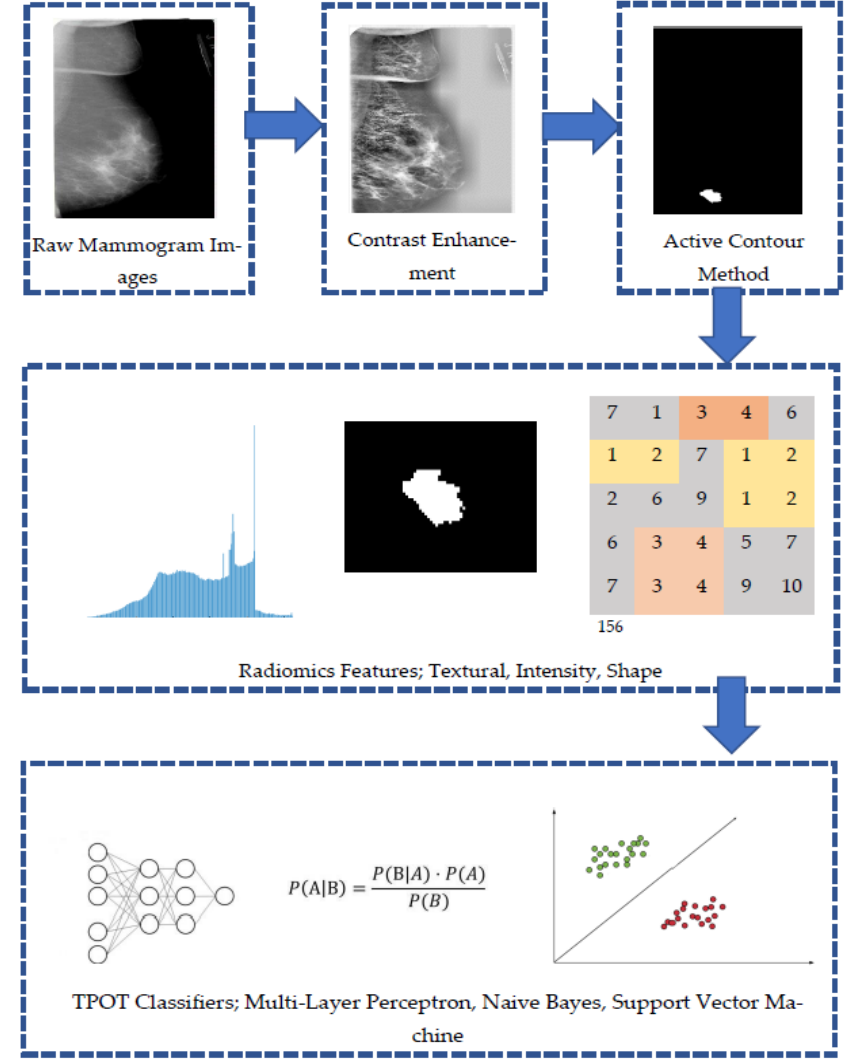
Figure 2. Outline of the proposed method to distinguish between benign and malignant breast mass.